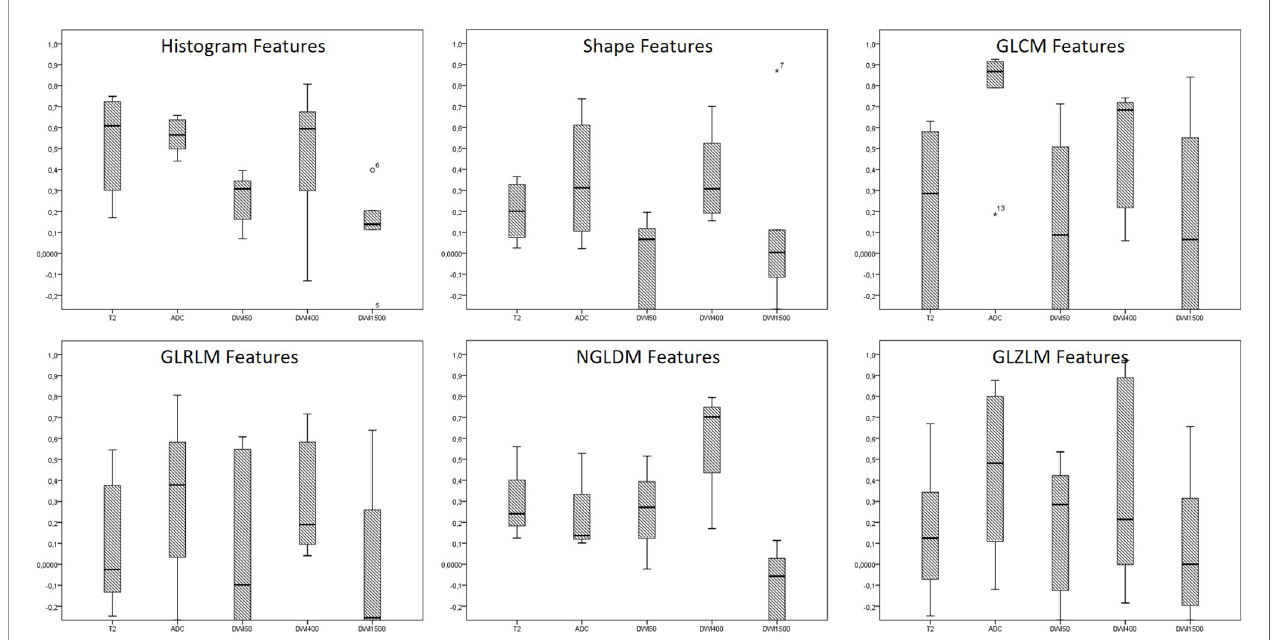
FIGURE 4 | The distribution of ICC across the different subclasses of radiomics features in the different MRI sequences. * are the